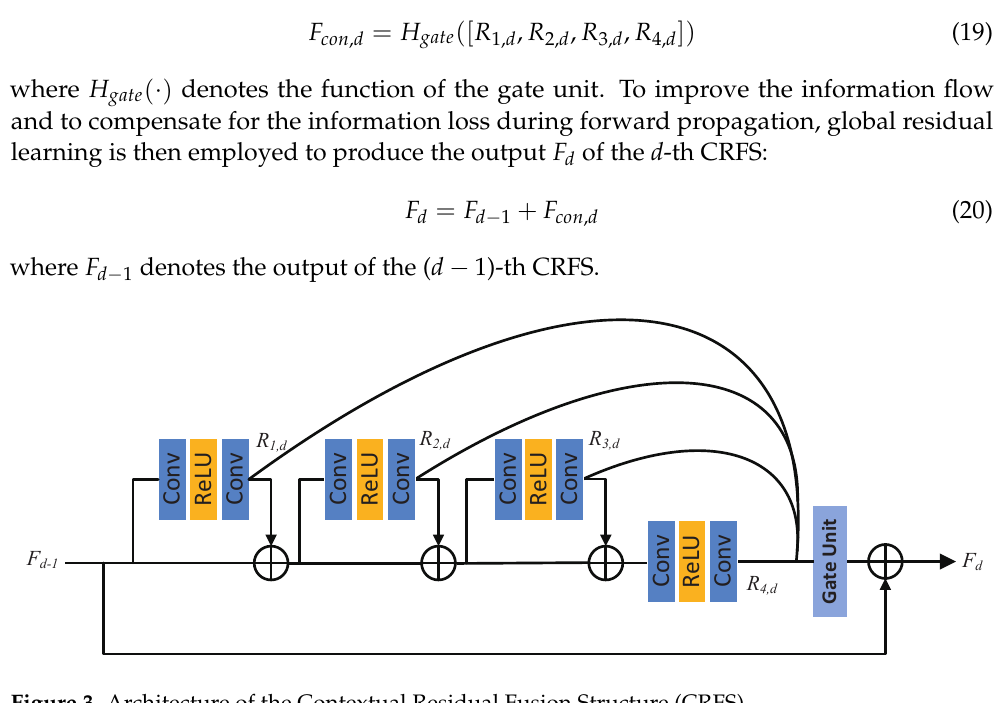
Figure 3. Architecture of the Contextual Residual Fusion Structure